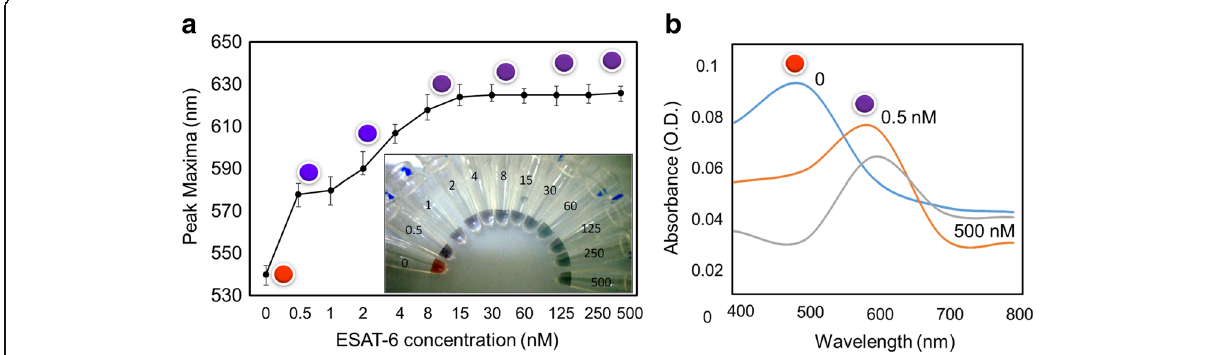
Fig. 5 ESAT-6 detection at higher concentrations. a Graphical representation for the detection of ESAT-6. Different concentrations of ESAT-6 was mixed with 60 nM of antibody, and after 30 min of incubation, GNP was added. Then 800 mM of NaCl was added to induce the color change. ESAT-6 from 0.5 nM was detected with the clear color change (red to blue). Photographs were taken by the digital camera as in figure inset. b Spectral changes at the wavelength from 400 to 800 nm. Peaks were indicated with the respective colored